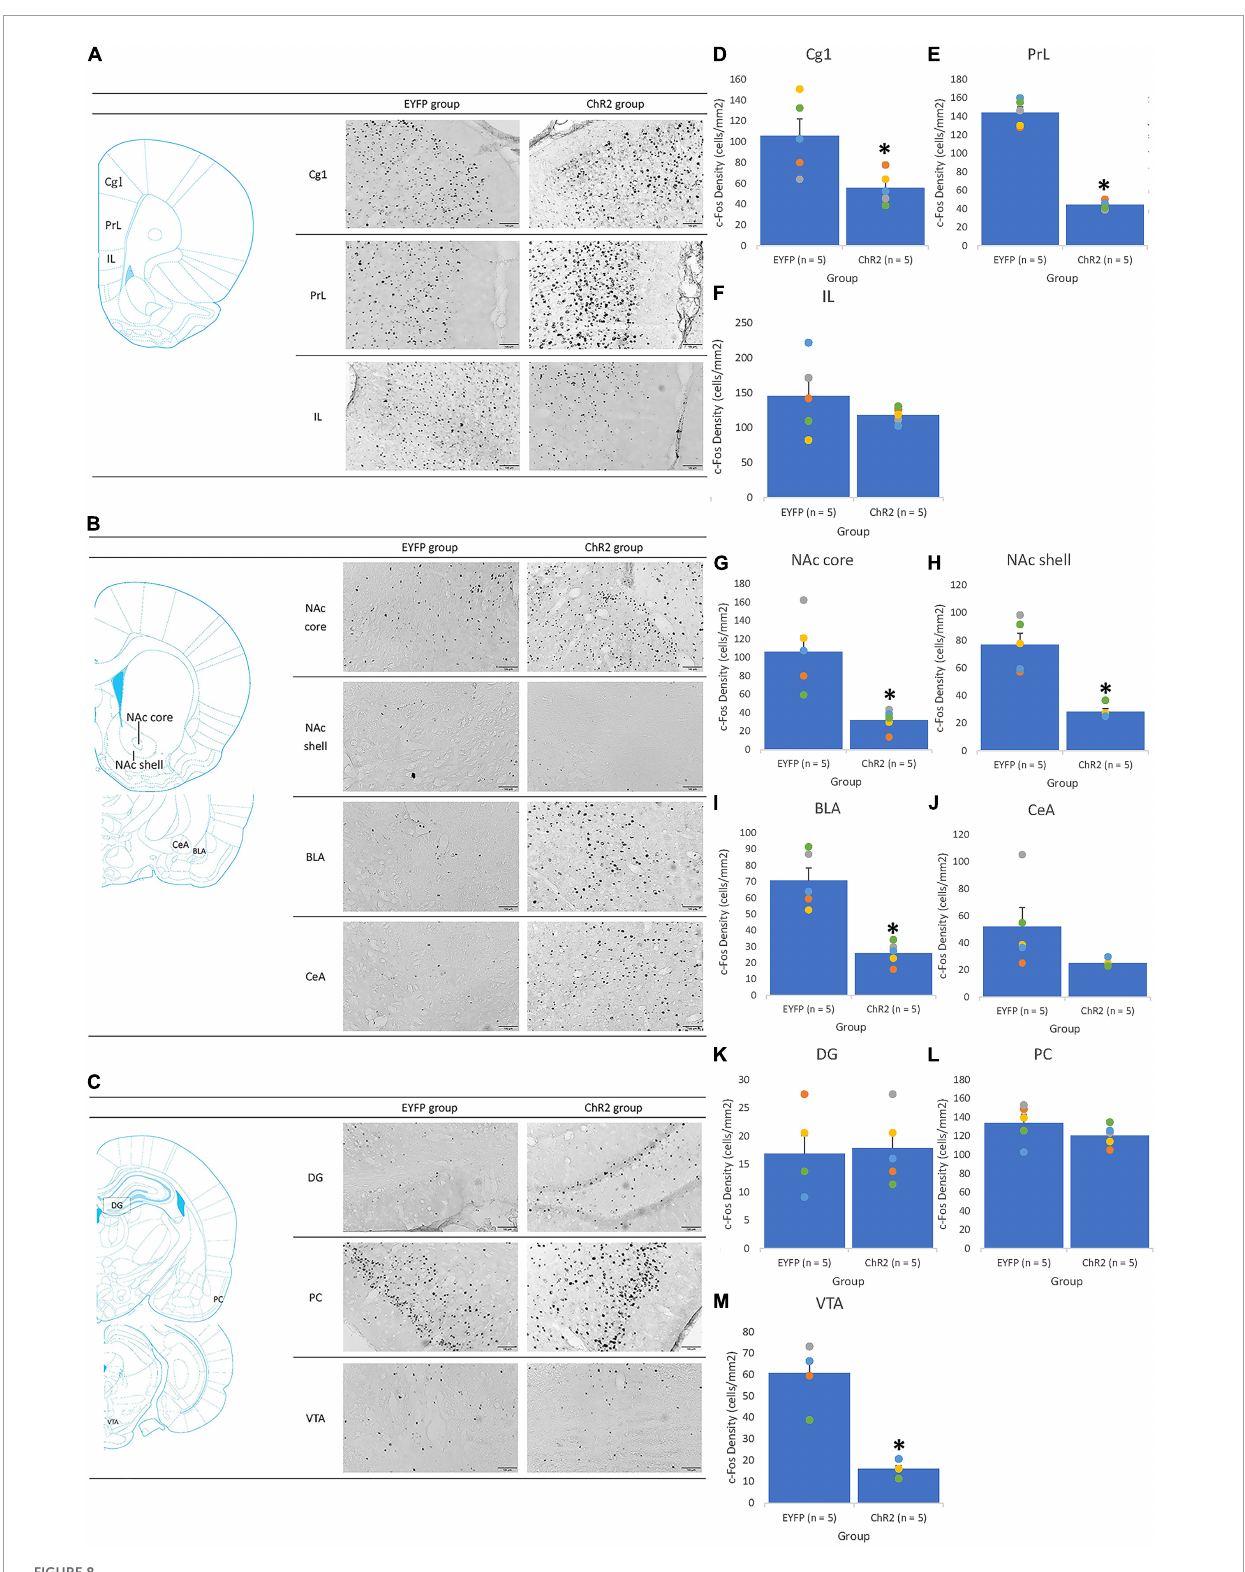
FIGURE8 The IL photostimulation was given in conditioning. An illustrated brain atlas showing (A) the cingulate cortex 1 (Cg1), prelimbic cortex (PrL), and infralimbic cortex (IL); (B) the nucleus accumbens core (NAc core), nucleus accumbens shell (NAc shell), basolateral amygdala (BLA), and central amygdala (CeA); (C) the dentate gyrus (DG), piriform cortex (PCl), and ventral tegmental area (VTA); c-Fos density in the (D) Cg1, (E) PrL, (F) IL, (G) NAc core, (H) NAc shell, (I) BLA, (J) CeA, (K) DG, (L) PC, and (M) VTA for the EYFP ( n = 5) and ChR2 ( n = 5) groups after IL optical stimulation and morphine-induced CTA in conditioning tests. ∗ p < 0.05 compared with the EYFP